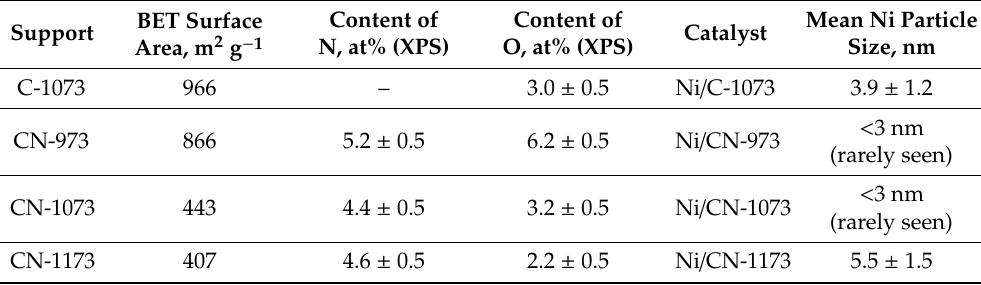
Table 1. Some characteristics of the supports and